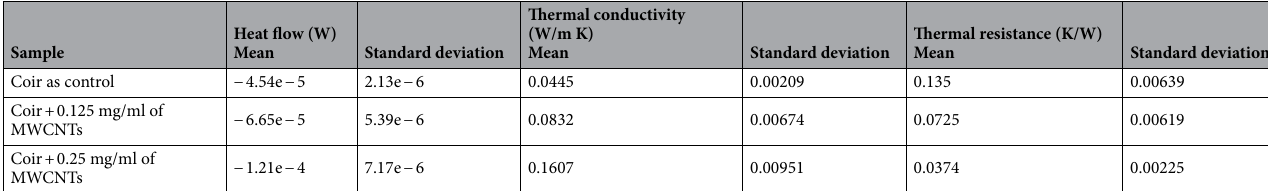
Table 3. Shows the mean of heat flow, thermal conductivity, and thermal resistance with their respective